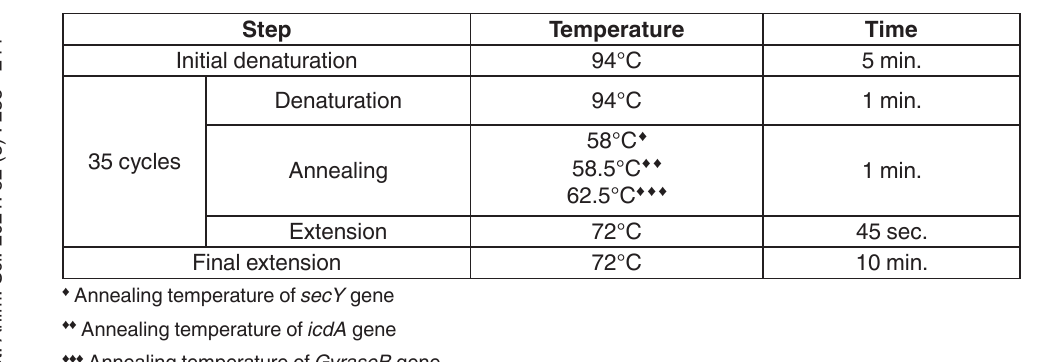
table 2. PCR protocol for the